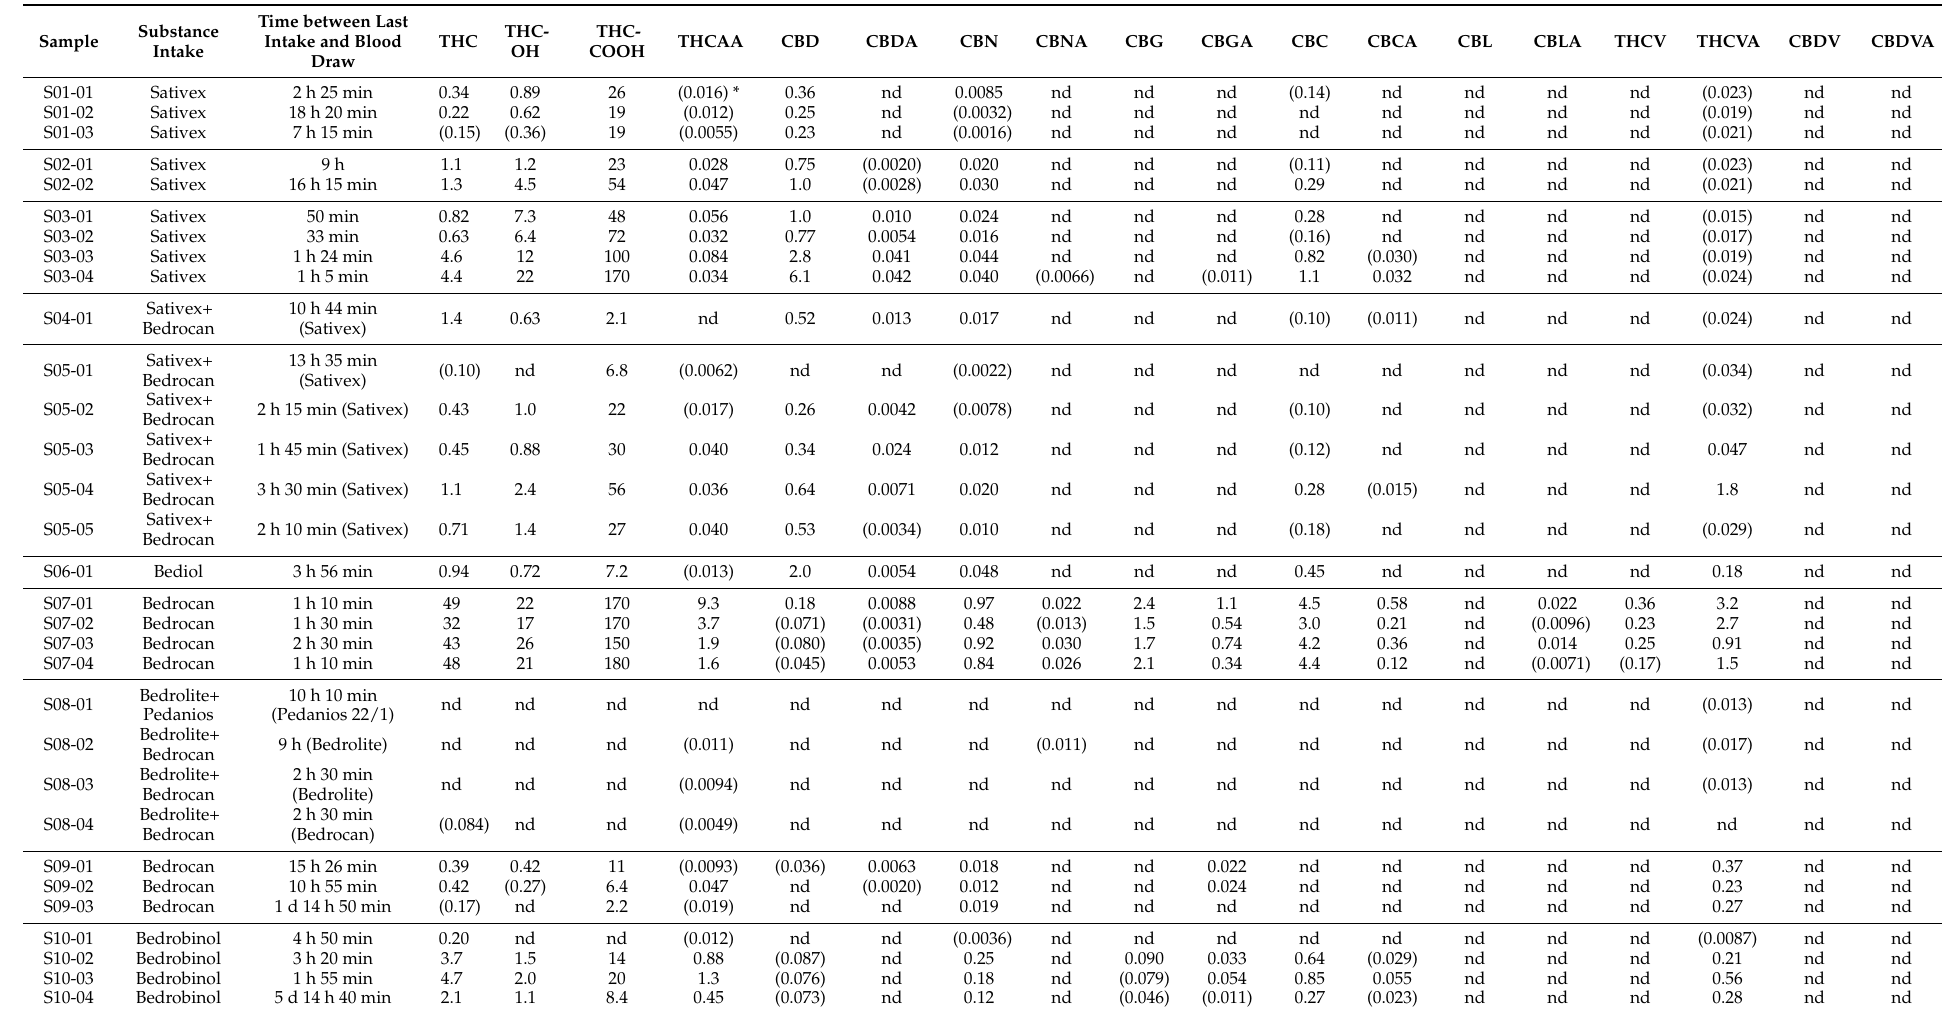
Table 1. Cannabinoid serum concentrations of the study collective in